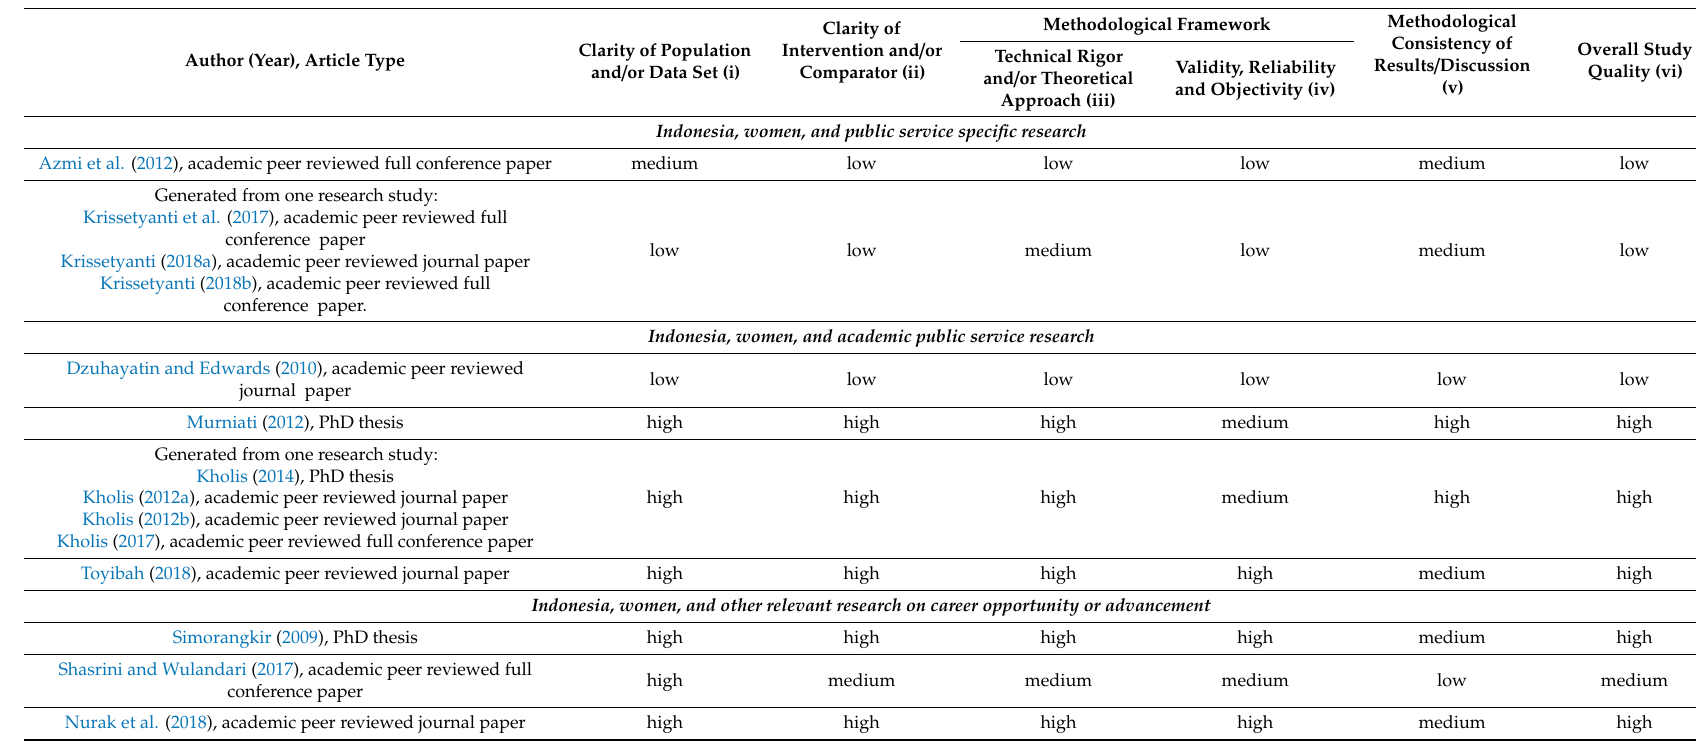
Table 2. Quality assessments of overviewed research studies (multiple papers from the same study assessed as